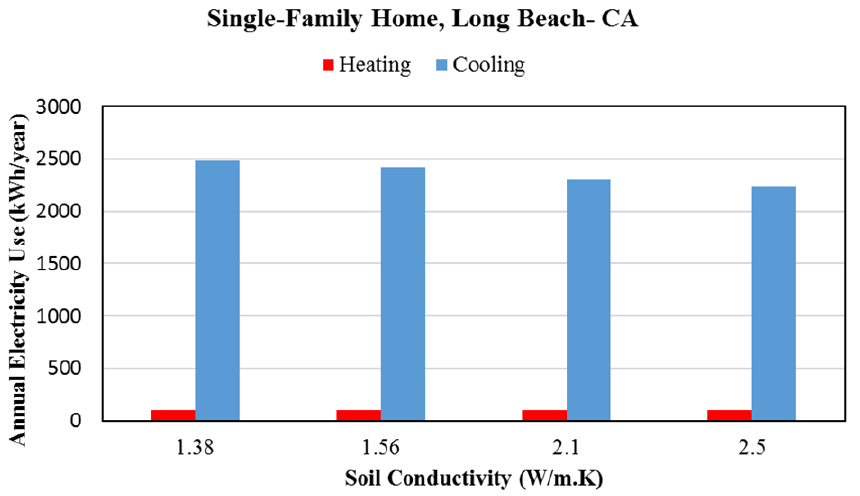
Figure 10. Impact of soil thermal conductivity on annual heating and cooling electricity end uses for 32 boreholes with 6.7 m (22 ft) depth when the prototypical house is located in Long Beach.